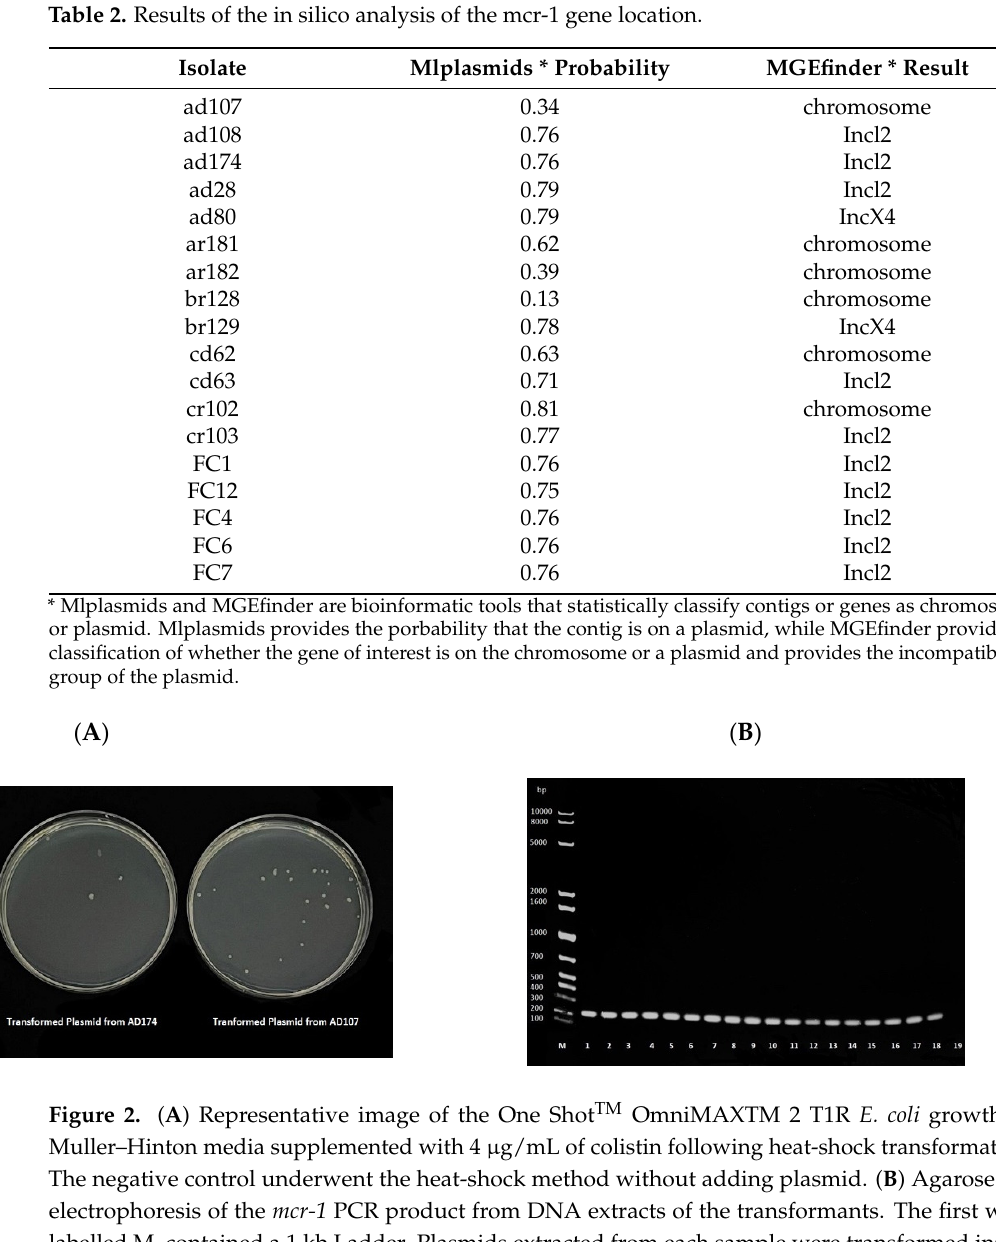
Figure 3. ( A ) Representative image of the trans-conjugant E. coli K12 growth in Muller–Hinton me- dia supplemented with 2 μ g/mL of colistin and 2000 μ g/mL of streptomycin following conjugation. The negative control underwent the conjugation method without adding donor cells. ( B ) Agarose gel electrophoresis of the mcr-1 PCR product from DNA extracts of the transconjugants. The first well, labeled M, contains a 1 kb Ladder. mcr-1 positive E. coli isolates (donors) underwent conjuga- tion with E. coli K12, strain IM93b (recipient). The origin of the DNA in each well were as follows, 1: ad28, 2: ad80, 3: ad107, 4: ad108, 5: ad174, 6: ar181, 7: ar182, 8: br128, 9: br129, 10: cd62, 11: cd63, 12: cr102, 13: cr103, 14: FC1, 15: FC4, 16: FC6, 17: FC7, 18: FC12, 19: PCR negative control. 2.5. Presistence of the mcr-1 Plasmids in Biofilms All isolates showed an ability to form biofilms as measured by the absorbance at 570 nm for the crystal violet dye (see Figure S1a,b). A Wilcoxon signed-rank test indicated that the log CFU/mL from the biofilms was significantly lower on day 6 compared to day 3 on both MH agar without colistin ( p = 0.033) and MH with colistin ( p = 7.6 × 10 − 6 ) (Figure 4).